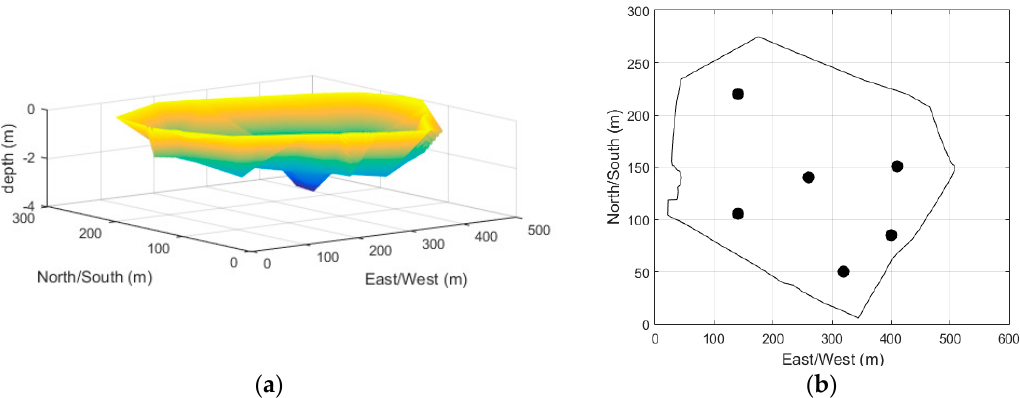
Figure 1. Profile and plain views of the bathymetry of the Pond Inlet wastewater stabilization pond (WSP). ( a ) Profile view of the Pond Inlet WSP bathymetry; ( b ) Plan view with sampling locations.